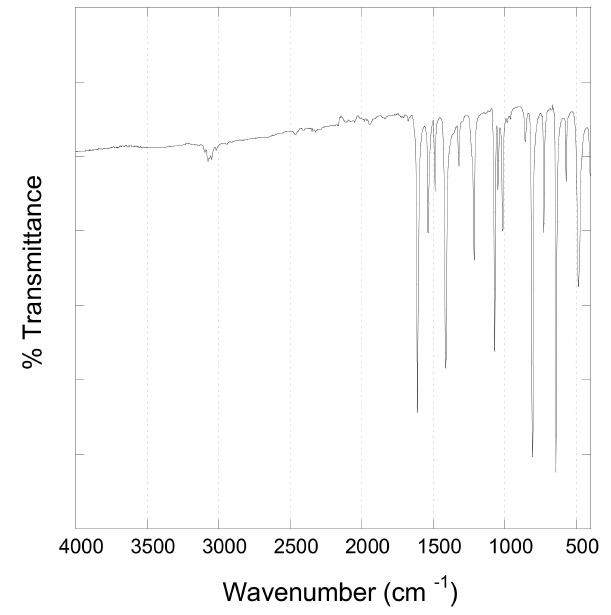
Figure 2. FTIR spectra of [ Zn(4,4 (cid:48) − bipy)Cl 2 ] ∞ sample. The thermal behaviour of the [ Zn(4,4 (cid:48) -bipy)Cl 2 ] ∞ sample prepared by sonochemical method, was observed using thermogravimetric (TG) analysis and differential scanning calorimetry (DSC) measurements (Figures 3 and 4). In the TG and the corresponding deriva- tive (dTG) curve, a main mass loss (and dTG peak) in the temperature range 380–600 ◦ C is observed. A weak shoulder in the range 500–660 ◦ C and a second dTG peak are